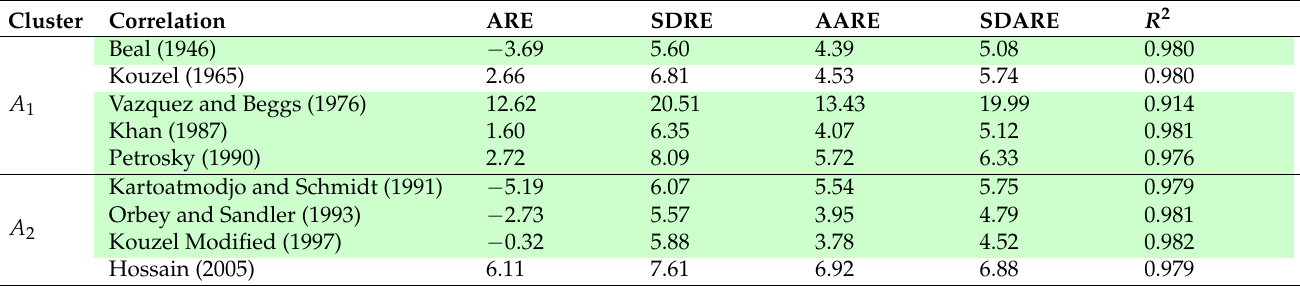
Table A2. Detailed metric values for all correlations and for µ ob range